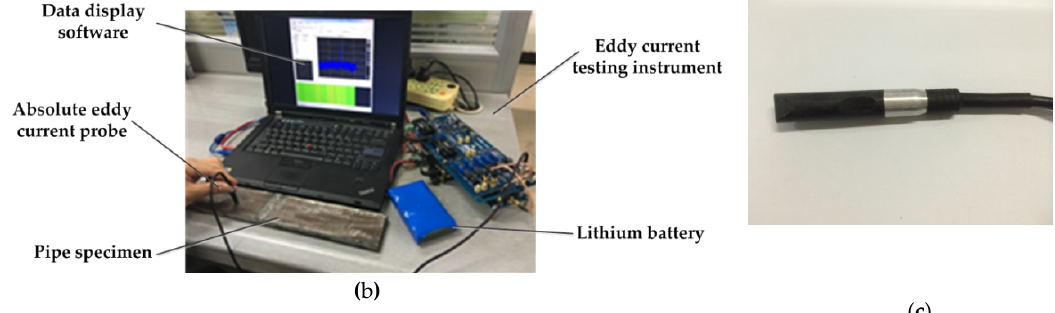
Figure 2. Experimental setup. ( a ) Block diagram of the experimental setup. ( b ) Physical layout of experimental setup. ( c ) Photograph of the employed external absolute eddy current probe. PC: Personal Computer; UART: Universal Asynchronous Receiver/Transmitter; DDS: Direct Digital Synthesizer;